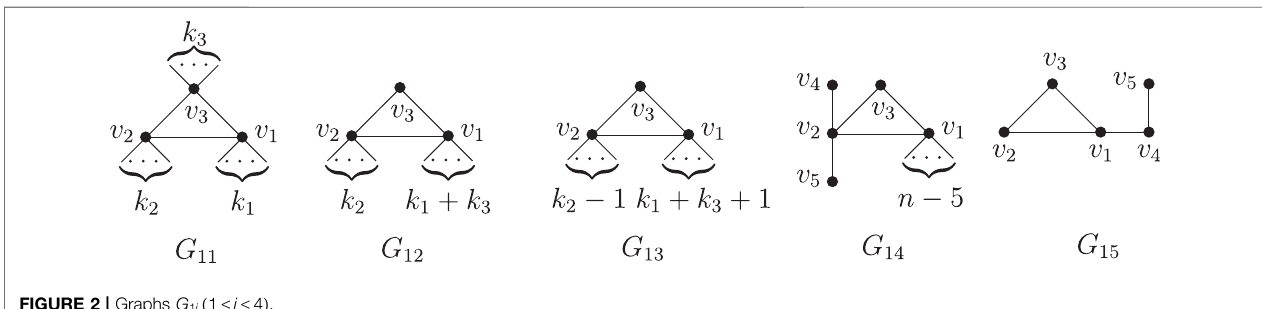
FIGURE 2 | Graphs G 1 i ( 1 ≤ i ≤ 4 )